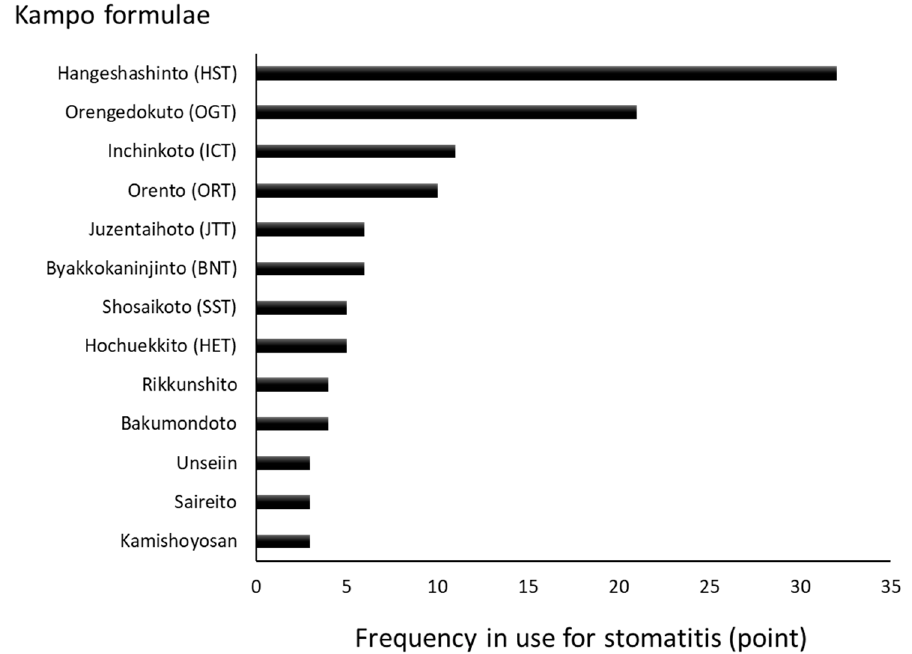
Figure 1. Kampo formulae frequently used for the treatment of stomatitis [4]. The trends in the use of the Kampo formulae at hospitals and faculties of oral surgery of dental/medical universities in Japan were surveyed. A total of 55 hospitals participated in the survey and rated the frequency of Kampo formulae use via a scale from 0 to 3. This graphic summarizes the results of rating.